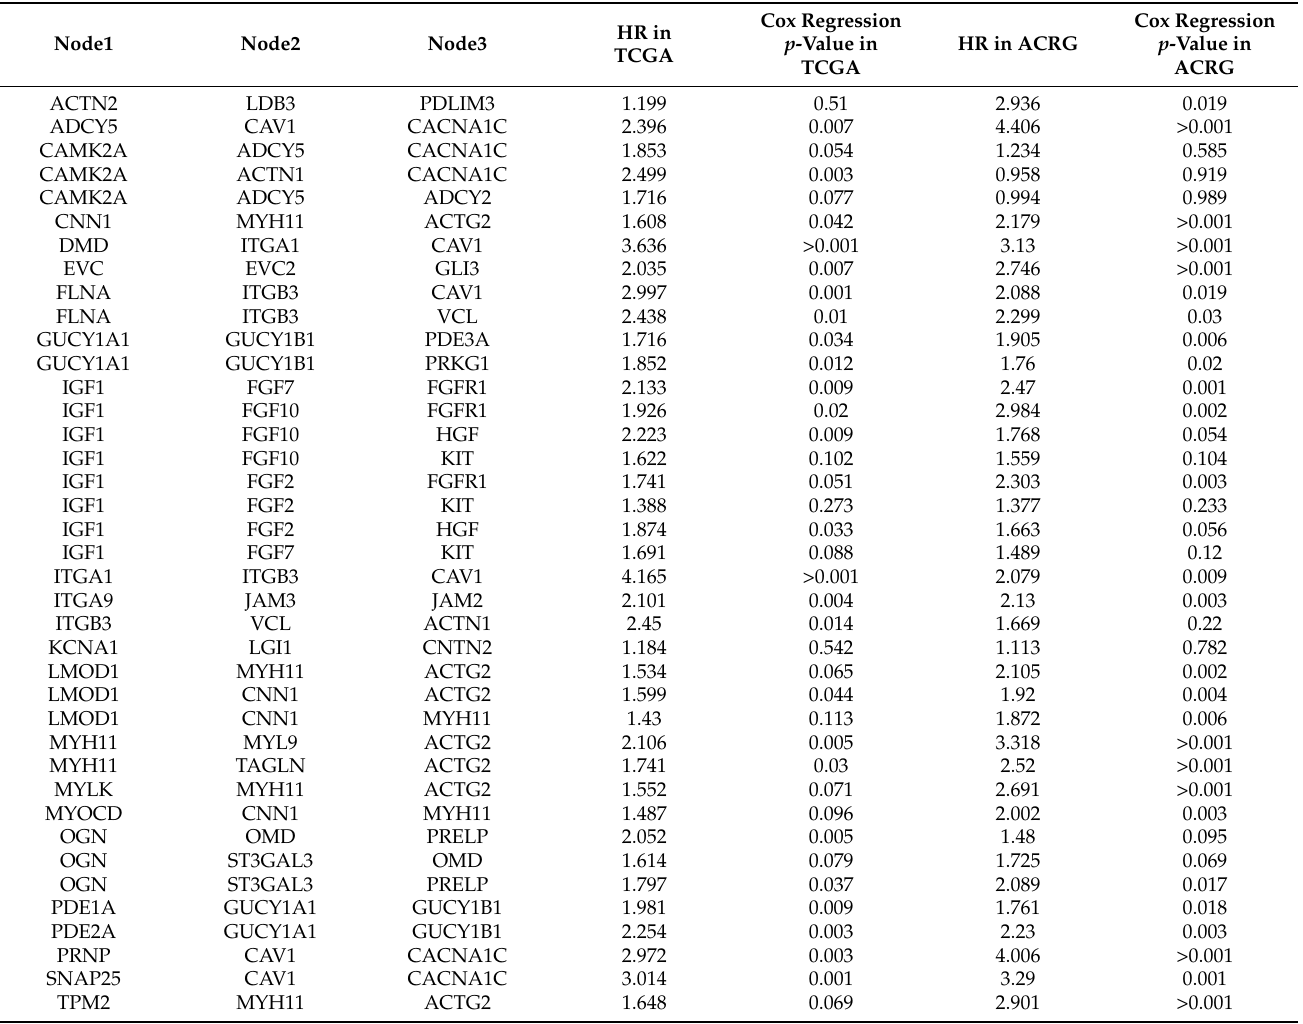
Table 2. The results of Cox regression analysis for the 39 top